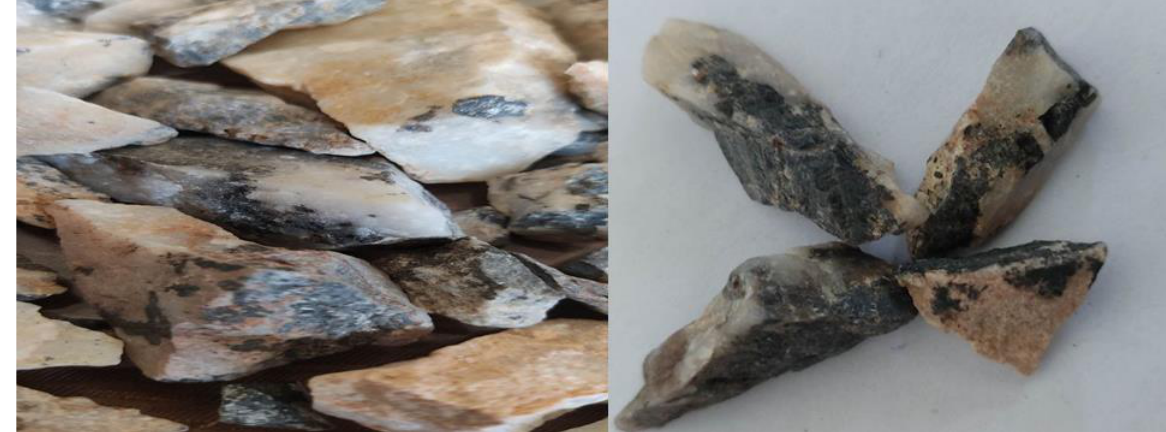
Figure 18. Photographs of selected wolframite sample and grains.